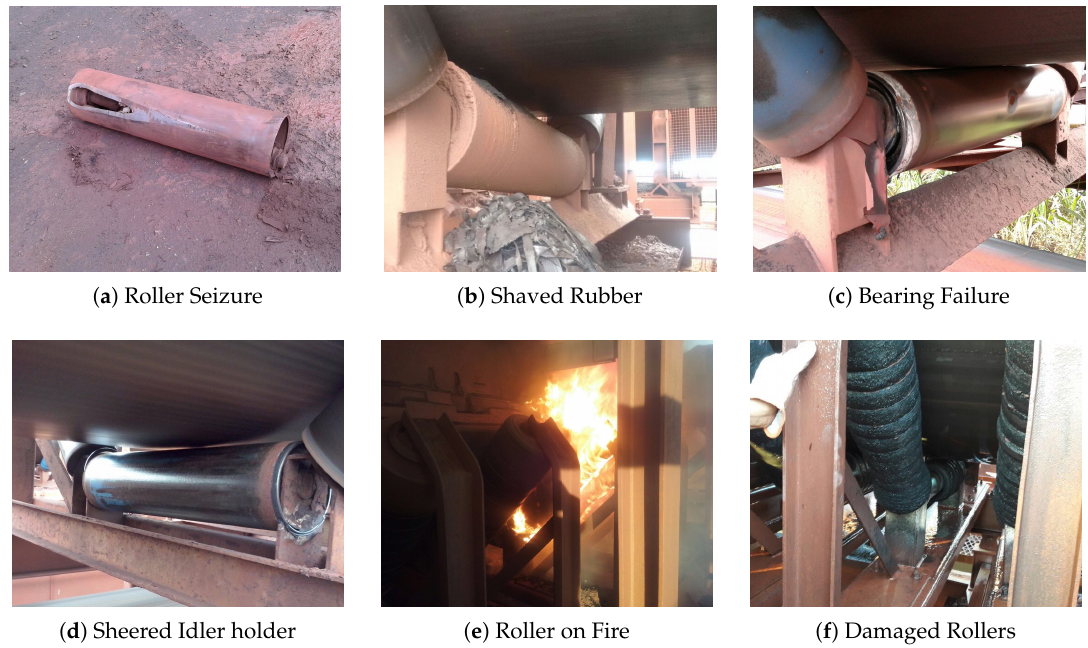
Figure 1. Rollers failures and its consequences: ( a ) Roller seizure that shaves the rubber of the BC, as demonstrated on ( b ). ( c ) A bearing failure affecting only the central roller. ( d ) Another bearing failure, this time, also affecting the idler holder. ( e ) An impact roller on fire and ( f ) rollers damaged by this